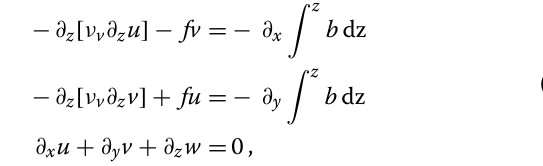
( � u � , � w � ) = ( − ∂ z , ∂ x )� . approximation in its horizontal momentum and conti-